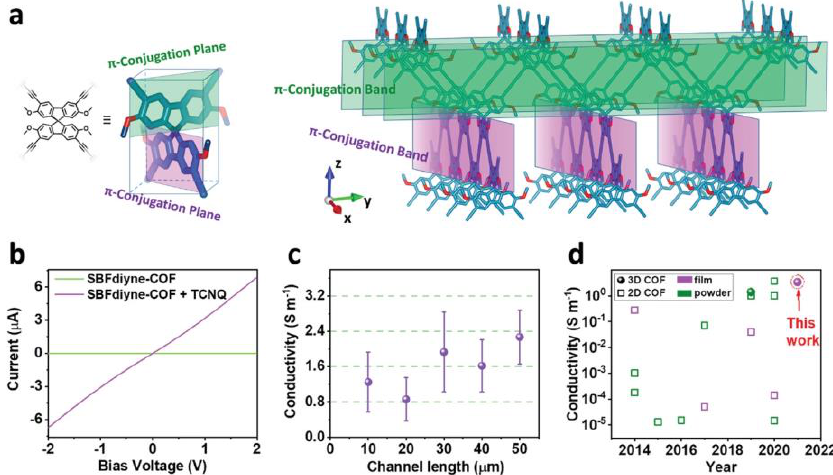
Figure 17. ( a – d ) Schematic illustrating of conductive SBFdiyne-COF film [63].